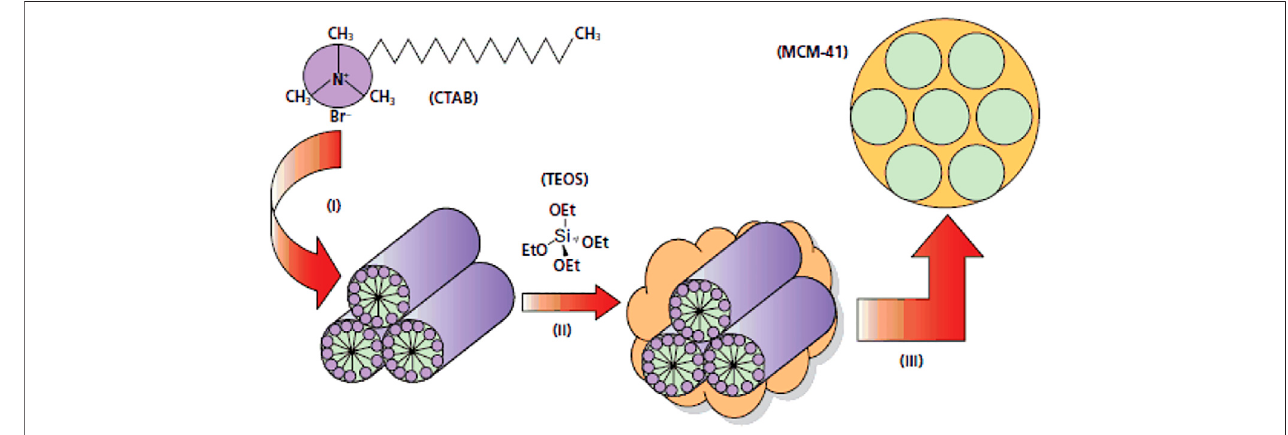
FIGURE 3 | Synthesis of MCM-41 in basic media (Janicke et al., 1999).